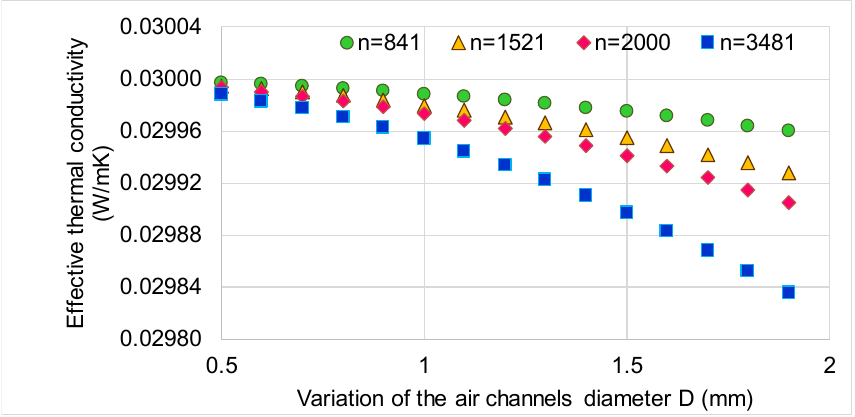
Figure 7. Variation of calculated effective thermal conductivity of the perforated panel as a function of the number of channels.